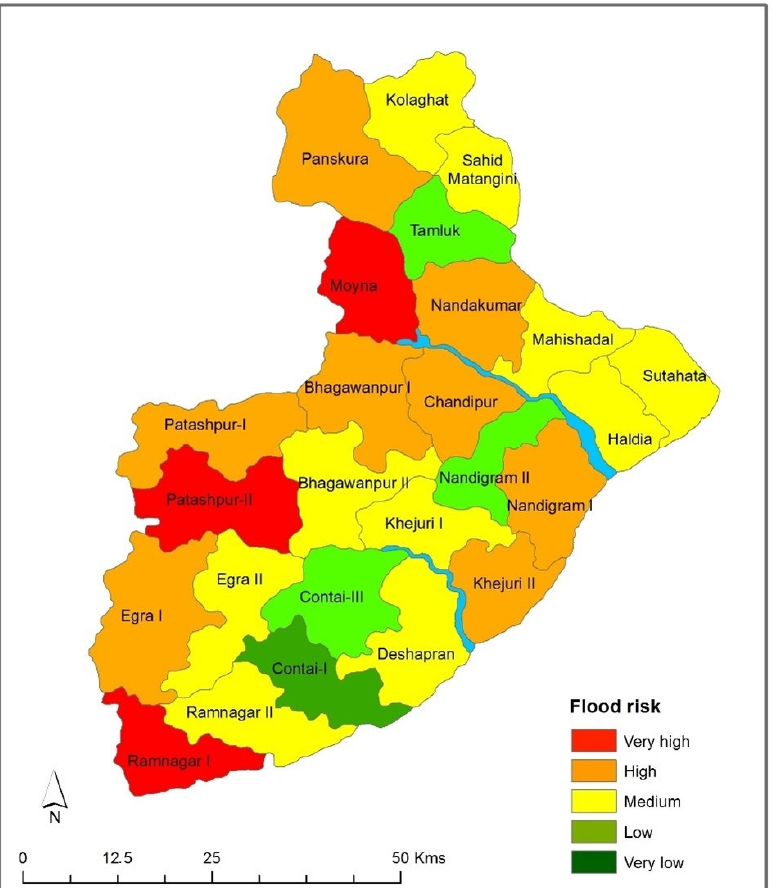
Figure 9. Flood risk map of Purba Medinipur district.